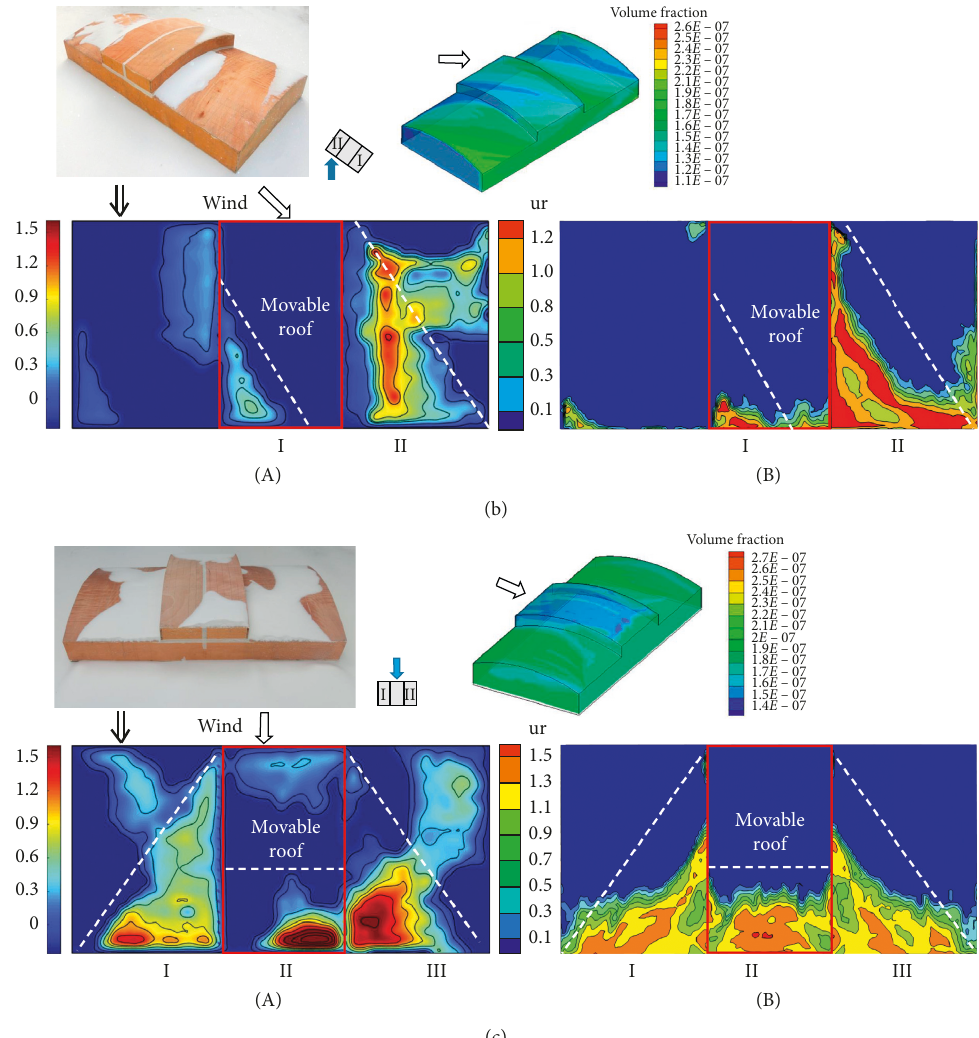
Figure 12: Comparison of results of experiments and simulations with different wind directions (A) Measurement (B) CFD simulation. (a) When wind direction is 0 ° . (b) When wind direction is 45 ° . (c) When wind direction is 90 °